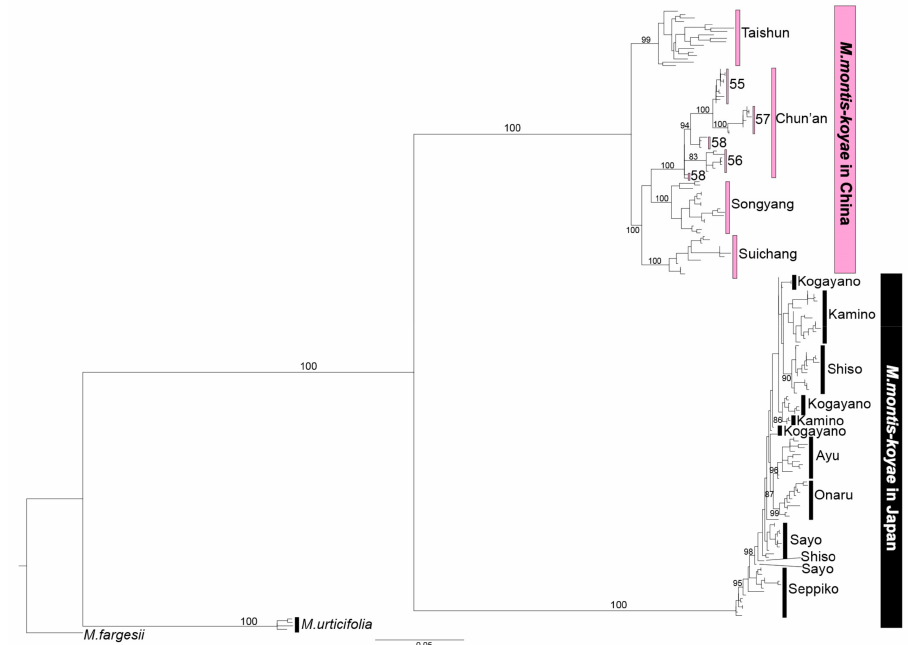
Figure 3. Maximum likelihood tree inferred from MIG-seq dataset, estimated by IQ-TREE 1.6.12. Numbers above branches are bootstrap values (BS, > 80% only) generated from 1000 replicates.